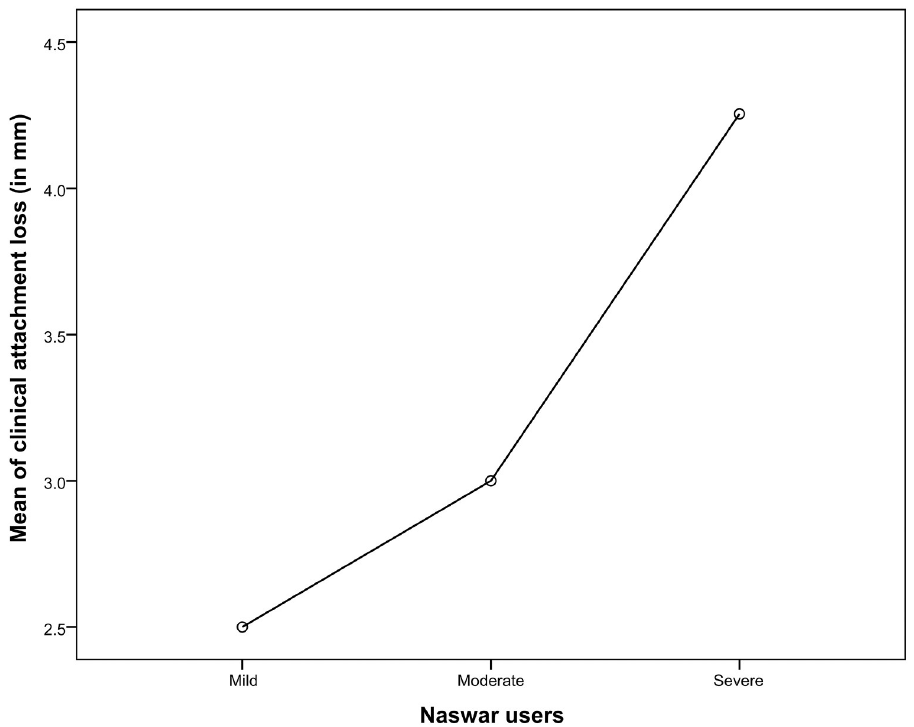
Fig 5. Mean score of clinical attachment loss, CAL (in